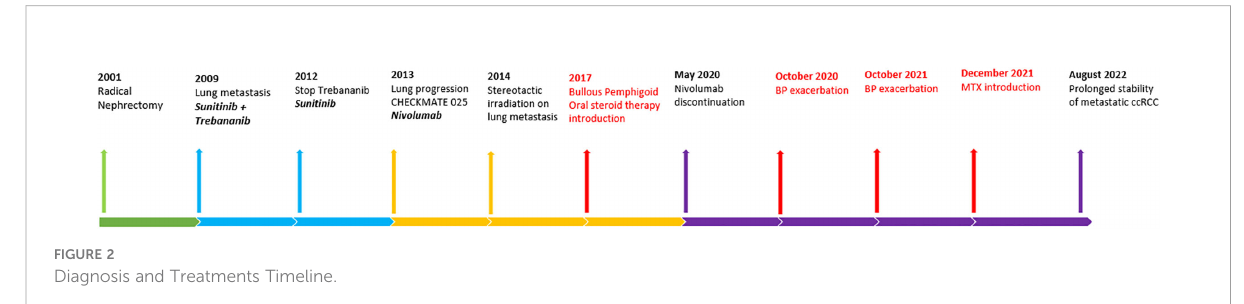
FIGURE 2 Diagnosis and Treatments